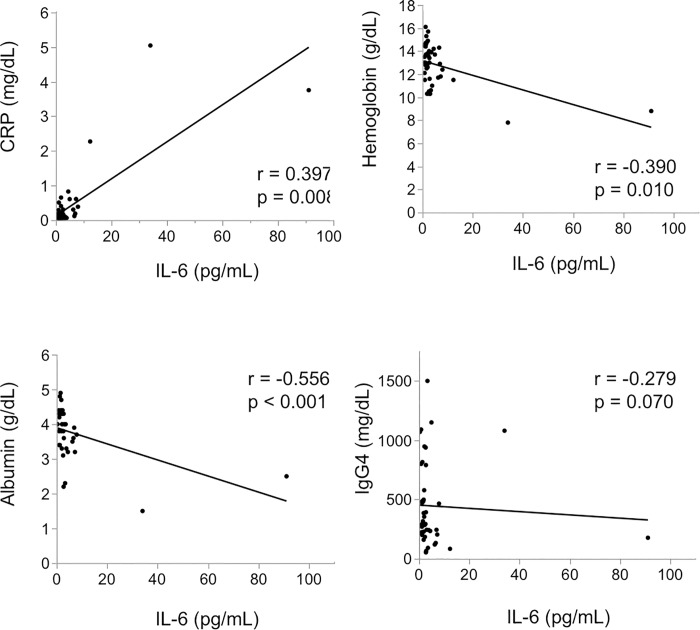
The correlative relationship between the serum IL-6 levels and CRP, hemoglobin, albumin, and IgG4.Bold lines are fitted curve. There was a positive significant correlation between IL-6 and CRP (a) and a negative significant correlation between Hemoglobin (b) and Albumin (c). There was no significant correlation with IgG4 (d).